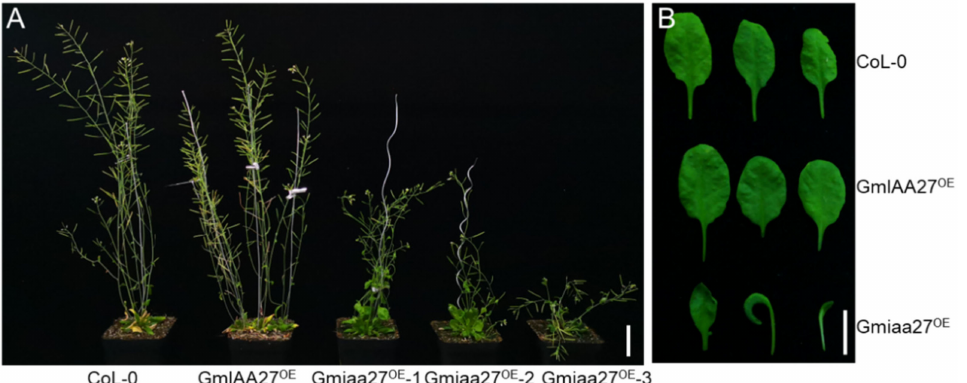
Figure 5. The functional confirmation of Gmiaa27 in Arabidopsis . ( A ) Plant morphology of Gmiaa27 transgenic plants at maturity; bar, 4 cm. ( B ) Leaf morphology of Gmiaa27 transgenic plants at maturity; bar, 1